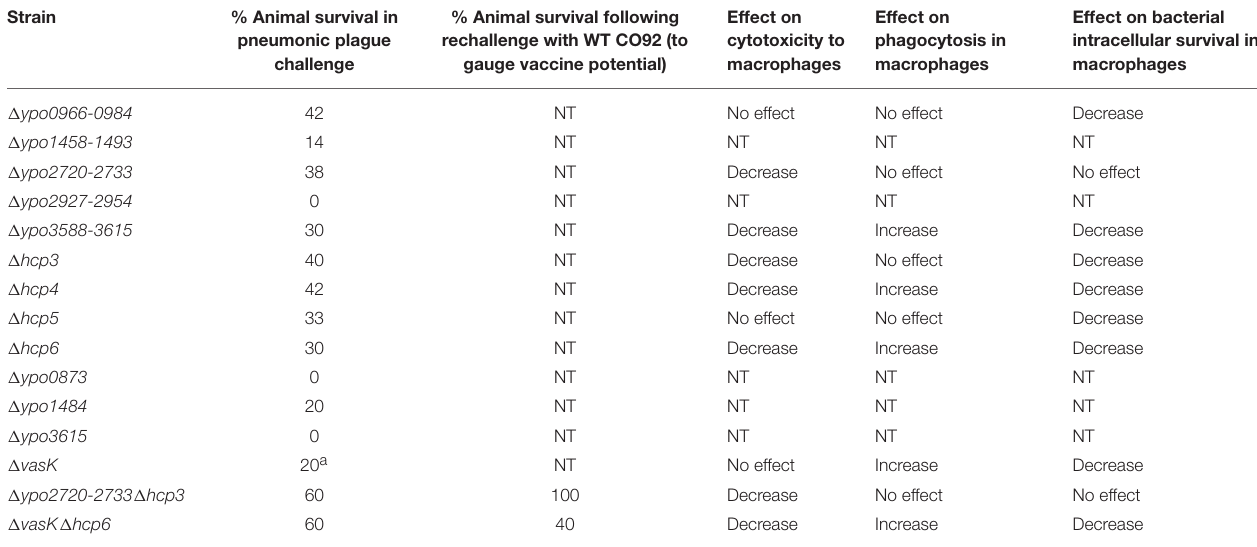
TABLE 3 | Summary of results for T6SS-associated mutant strains in mice and in vitro assays.